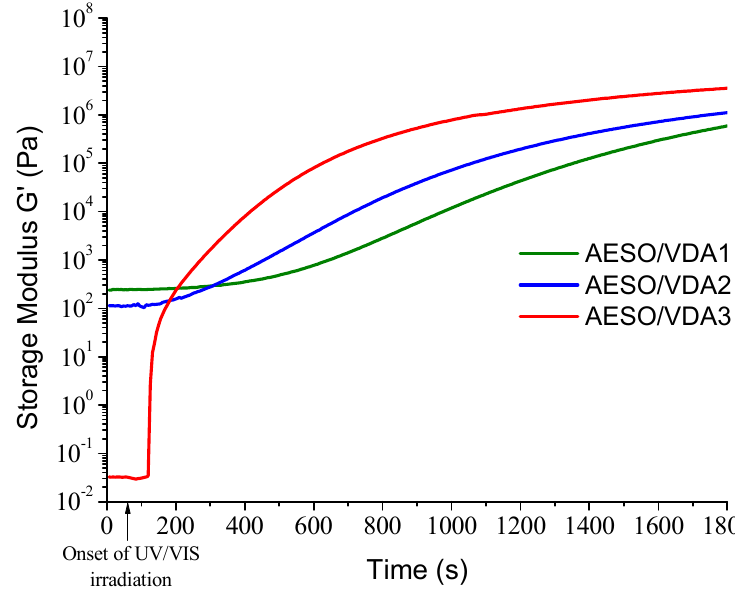
Figure 4. The irradiation time dependencies of the storage modulus G’ of the resin series AESO/VDA.